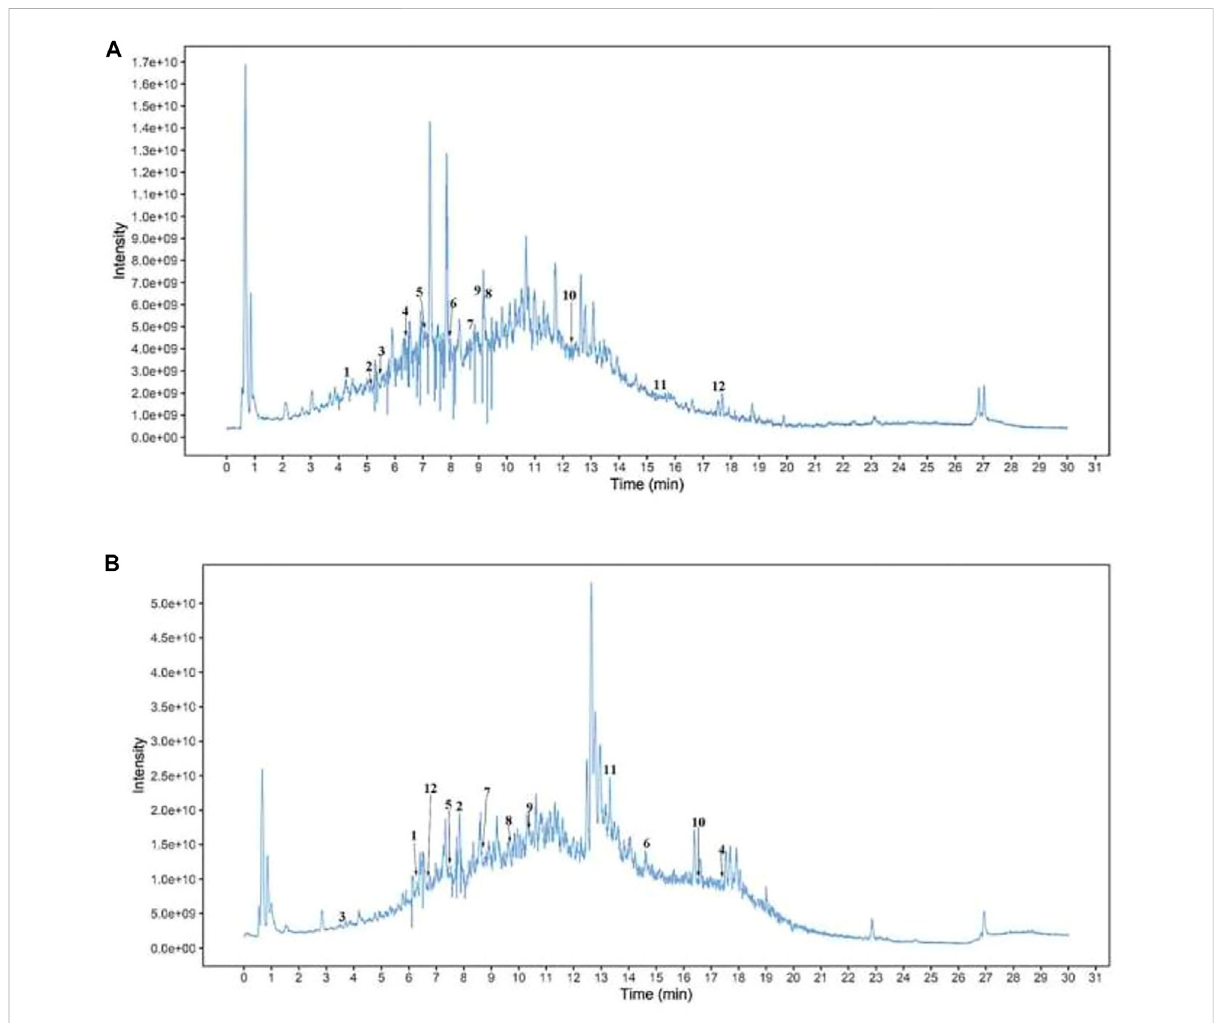
FIGURE 1 Metabolites inAOF. Total ion current pattern of (A) positive ions and (B) negative ions detected byUHPLC-QTOF-MS of AOF. 1: citrate; 2:lauryl sulfate; 3:Benzene-1,2,4-triol; 4: 5,9-dihydroxy-5,7,7-trimethyl-4,5a,6,8,8a, 9-hexahydro-1H-azuleno [5,6-c]furan-3-one; 5: isorhamnetin; 6: D-gluconic acid; 7: 6-gingerol; 8: D-(+)-malic acid; 9: (+)-nootkatone; 10: alpha-cyperone; 11: choline [M]+; 12: